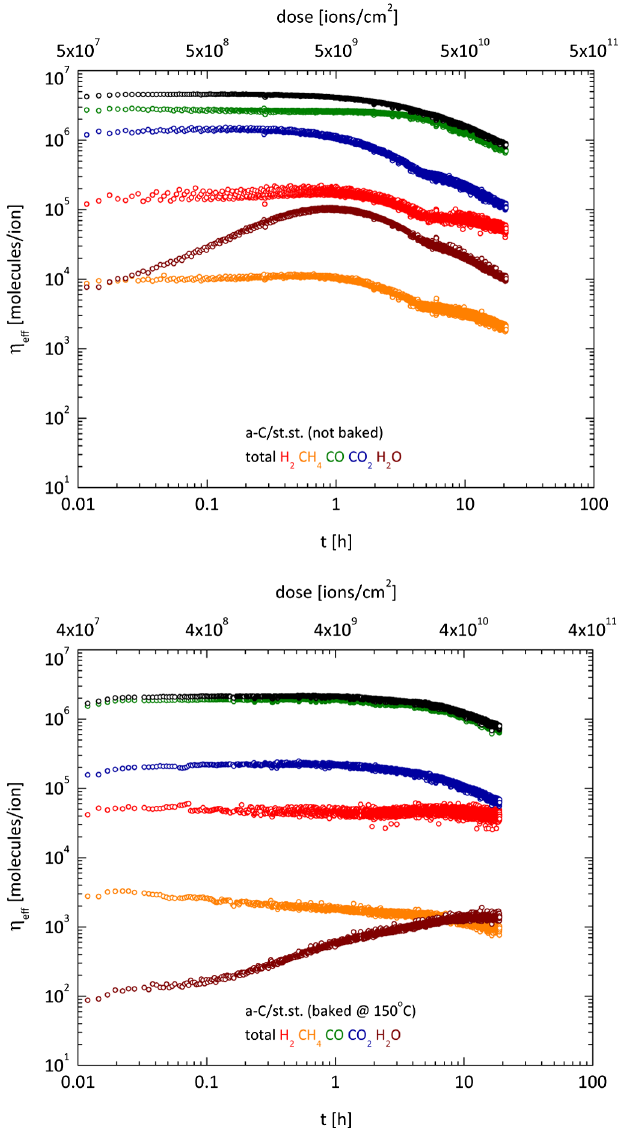
FIG. 2. Heavy-ion induced desorption yields measured for the unbaked (top) and 150 (cid:3) C baked (bottom) amorphous carbon (a-C) film deposited onto stainless steel vacuum chamber #2. Both targets were continuously bombarded under (cid:1) ¼ 89 : 2 (cid:3) with 4 : 2 MeV = u Pb 54 þ ions, note the 20% less ion flux for the experiment with the baked test